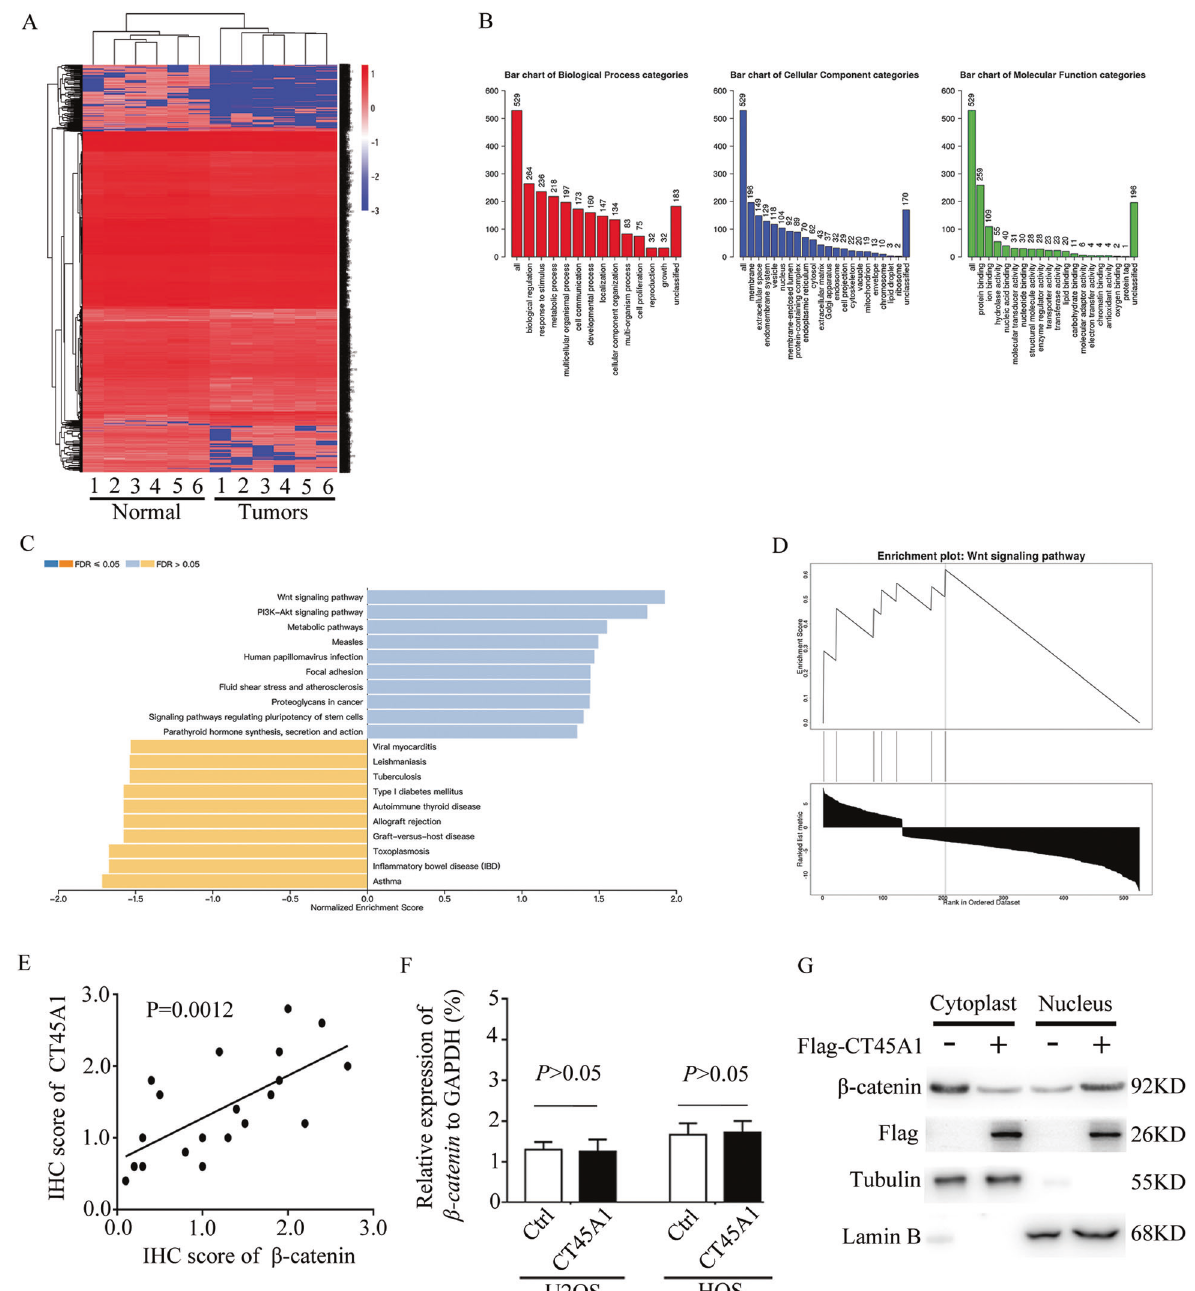
Fig. 5 CT45A1 promotes the expression of EMT markers through β -catenin. A RNA-seq analysis of U2OS cells with CT45A1 overexpression. B GO analysis of data in ( A ). C , D KEGG analysis of data in ( A ). E linear correlation analysis of CT45A1 and β -catenin in osteosarcoma. F qRT-PCR of β -catenin in osteosarcoma cell lines with CT45A1 overexpression. G WB of β -catenin in cytoplast and nucleus in osteosarcoma cells with CT45A1